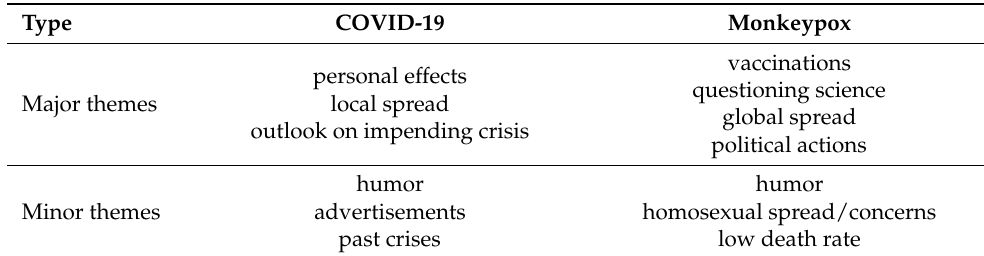
Table 2. Comparison of themes between COVID-19 and